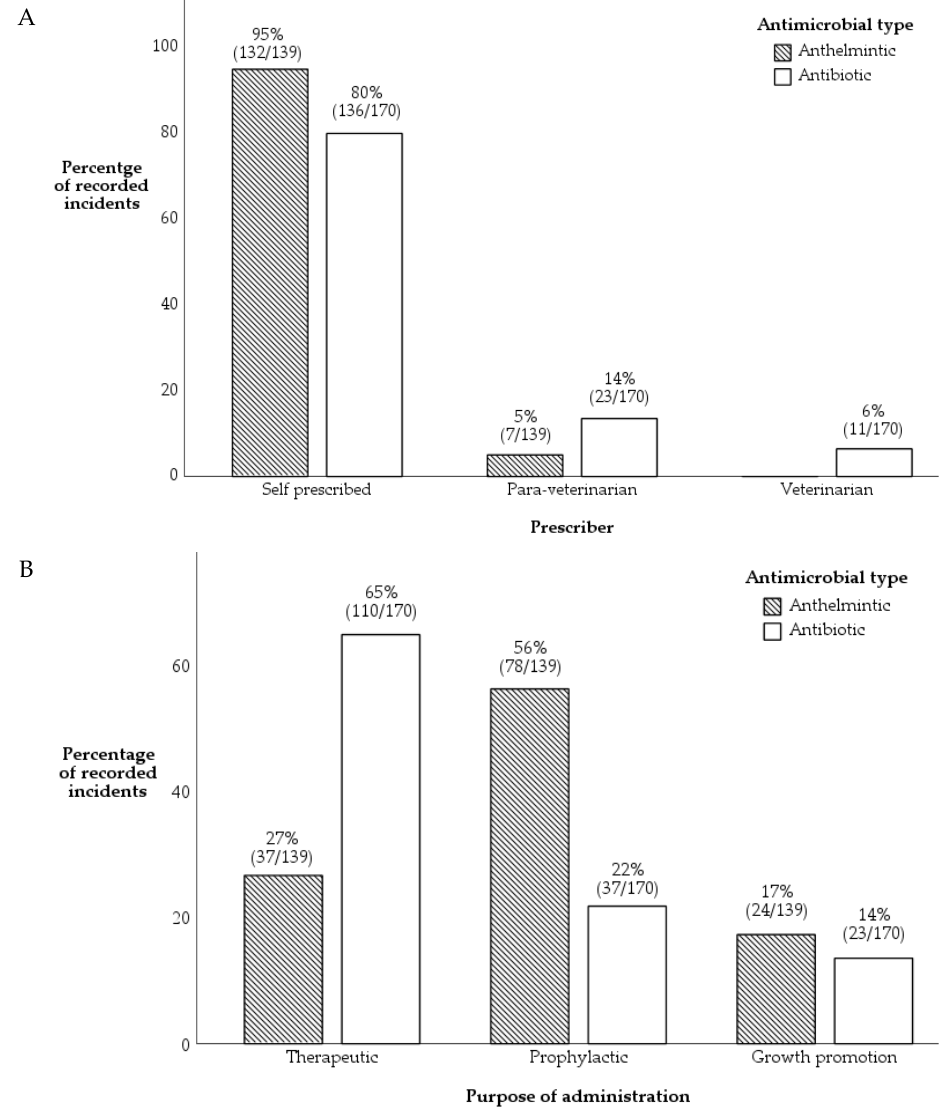
Figure 1. Association of 309 incidents where antimicrobials were used (anthelmintics n = 139, antibiotics n = 170) with ( A ). prescribing pattern (Fisher’s exact test, p < 0.001), and ( B ). purpose of administration (X2 = 48, p < 0.001) in 276 enterprises located in Central and Western division of Viti Levu, Fiji.